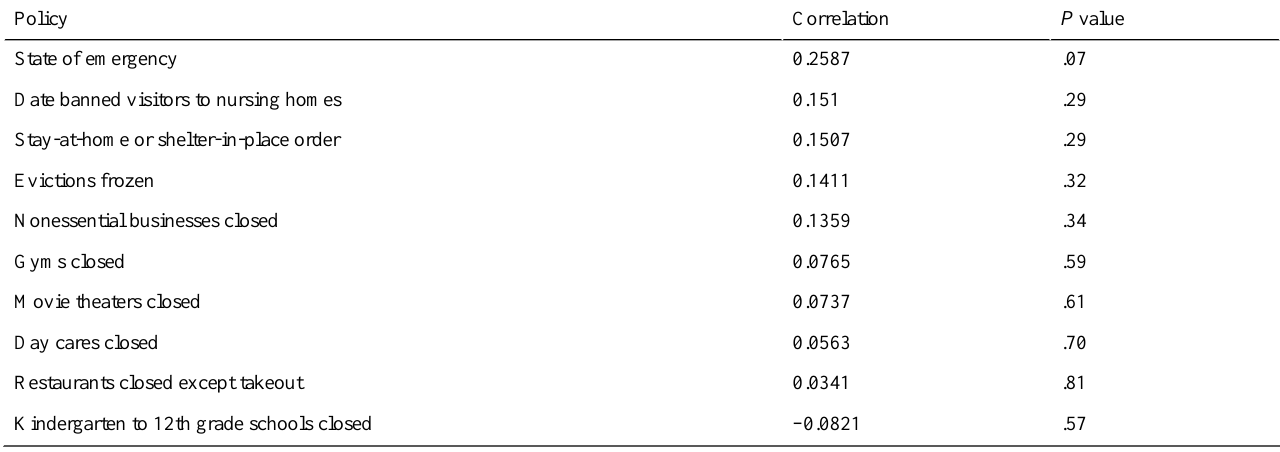
Table 3. Pearson correlations between the cumulative number of confirmed COVID-19 cases on May 10, 2020, and the dates on which policies were released in each